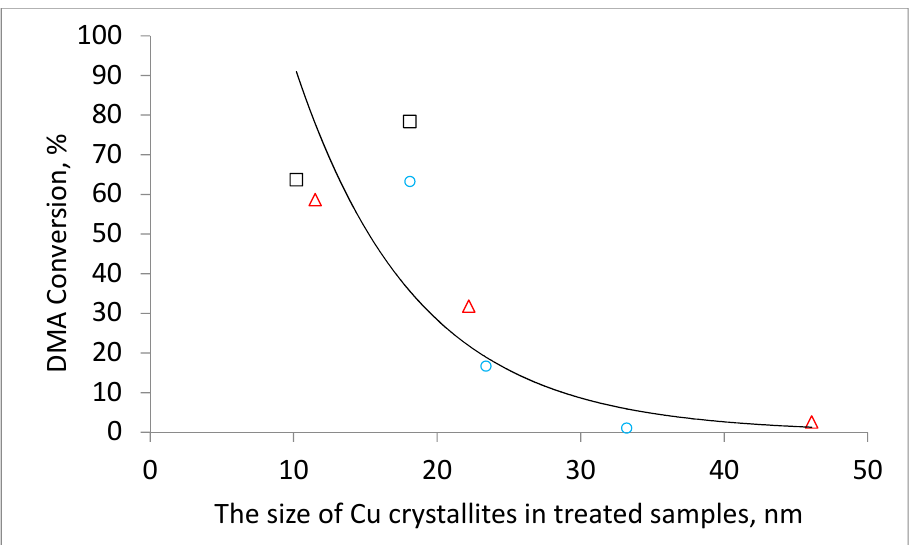
Figure A2. A correlation between the DMA conversion and the size of the Cu crystallites in the